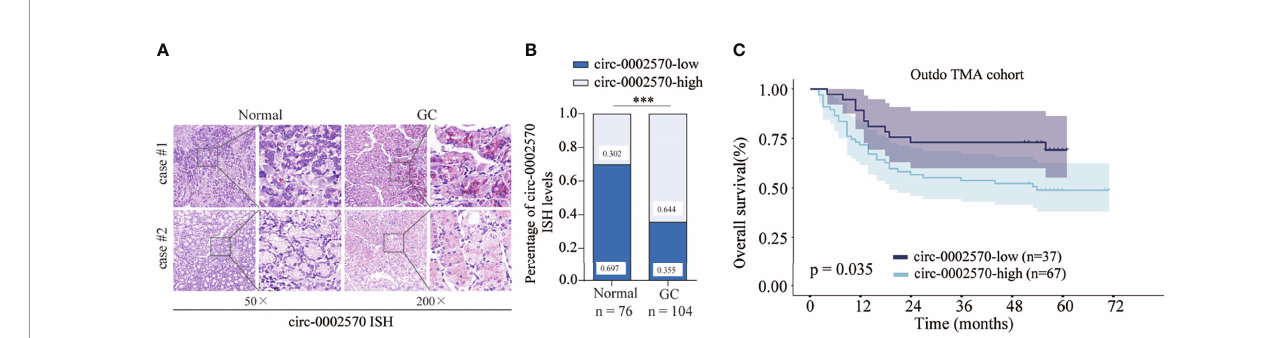
FIGURE 2 | The expressing pattern of circ-0002570 in GC specimens and normal gastric specimens, and its clinical signi fi cance. (A, B) Percentage of circ-0002570 ISH levels in normal specimens ( n = 76) and GC specimens ( n = 104). (C) Survival assays based on circ-0002570 expression in 104 patients from Outdo TMA cohort. *** p